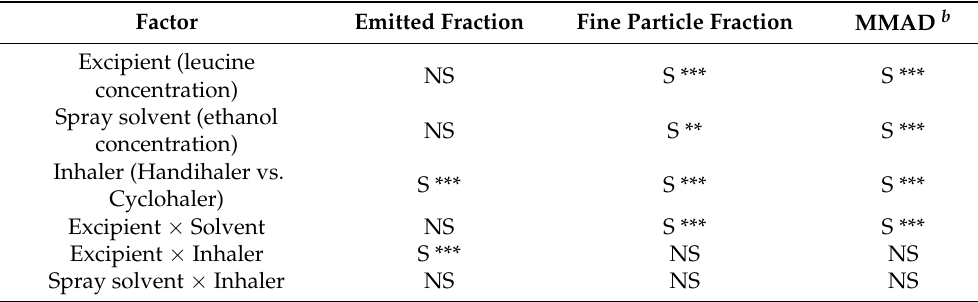
Table 3. Analysis of the influences of the excipient composition, the spray solvent composition, and the inhalation device on the in vitro aerodynamic performance of the spray-dried formulation a . Factor Emitted Fraction Fine Particle Fraction MMAD b Excipient (leucine NS S *** S *** concentration) Spray solvent (ethanol NS S ** S *** concentration) Inhaler (Handihaler vs. S *** S *** S *** Cyclohaler) Excipient × Solvent NS S *** S *** Excipient × Inhaler S *** NS NS Spray solvent × Inhaler NS NS NS a The influences were analyzed by three-way analysis of variance. The significance of each influence is indicated by one of the following abbreviations: NS: not significant, S **: significant at p < 0.01, S ***: significant at p < 0.001. b Mass median aerodynamic